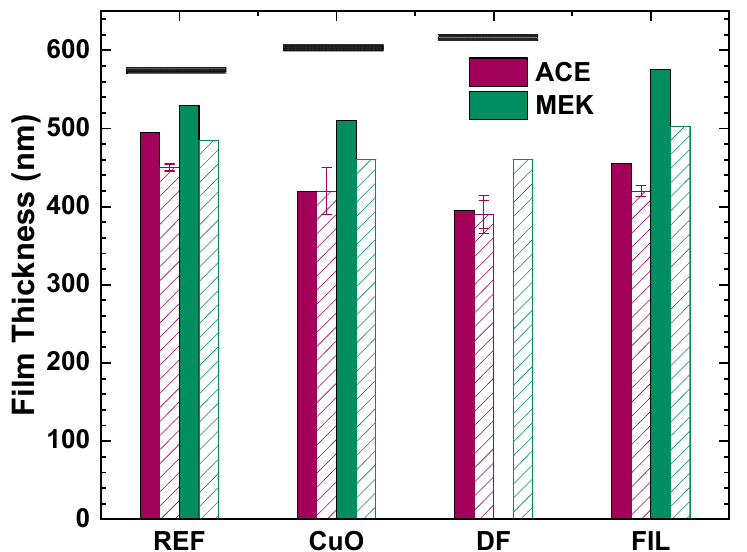
Figure 7. Film thickness of Phase 2 CuO/PMMA nanocomposite films, as measured by ellipsometry prior to EBL (solid bars) and as calculated by stylus profilometry of the contrast patterns after development (striped bars). Magenta bars correspond to acetone-based nanocomposites; green bars correspond to MEK-based nanocomposites. Horizontal black lines denote the film thickness of the respective samples from Phase 1.